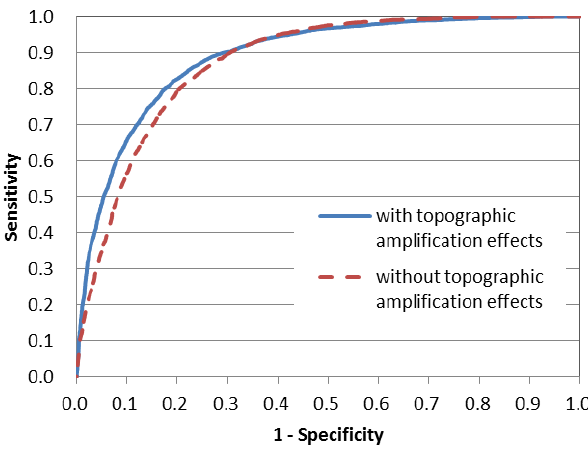
Fig. 12. Receiver operating characteristic (ROC) curve.